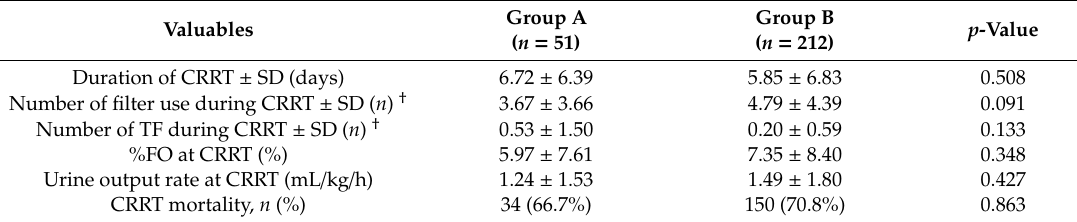
Table 7. Comparison of outcomes and parameters between the groups in patients receiving